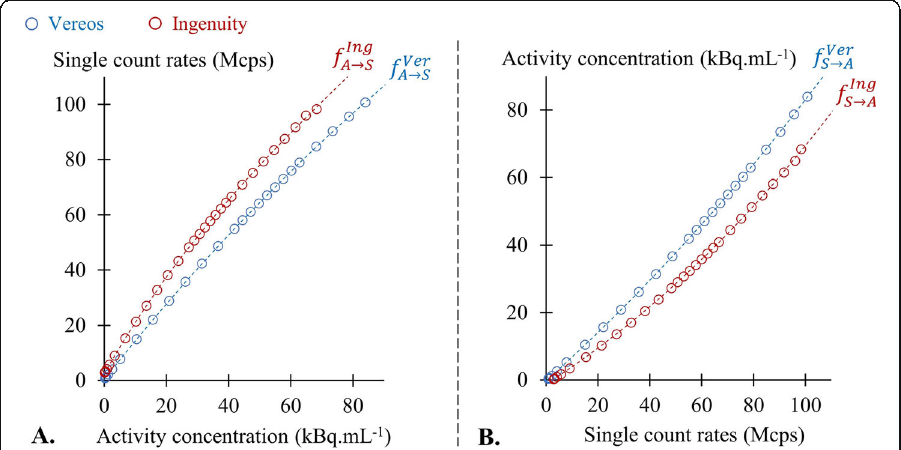
Fig. 2 Relationships between single-count rates and activity concentration obtained from the NEMA count- rate test with the Ingenuity (red) and the Vereos (blue) cameras, with the double-exponential regressions predicting: a Single-count rates based on activity concentration ( f Ing and Vereos) and b Activity concentration based on single-count rates ( f Ing Ingenuity and Vereos)